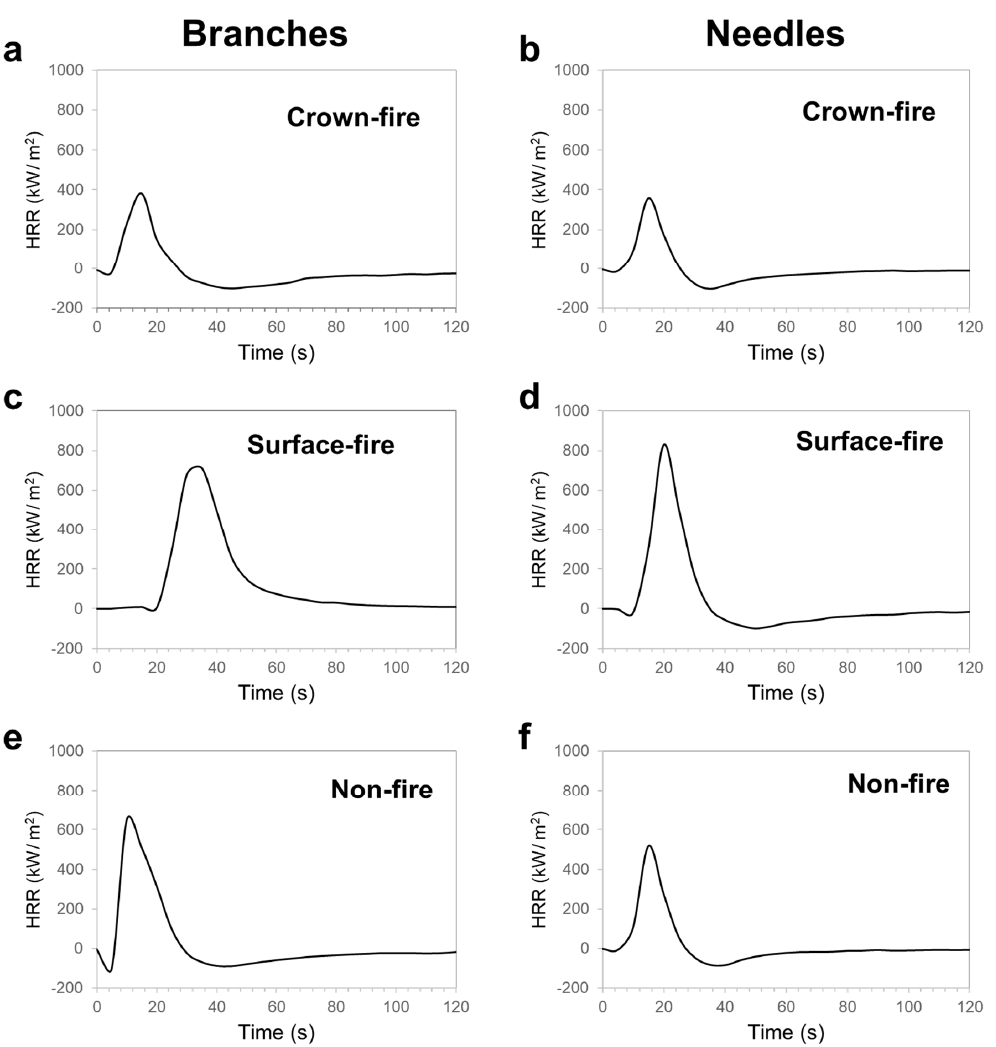
Figure 8. Heat release rate of lab-dried needles and branches across fire regimes. Heat release profiles of small branches ( left ) and needle beds ( right ) from either surface fire ( a , b ), crown fire ( c , d ) or non-fire ( e , f ), as measured by cone calorimetry, are shown. The examples shown are representative profiles from three independent replicate analyses.